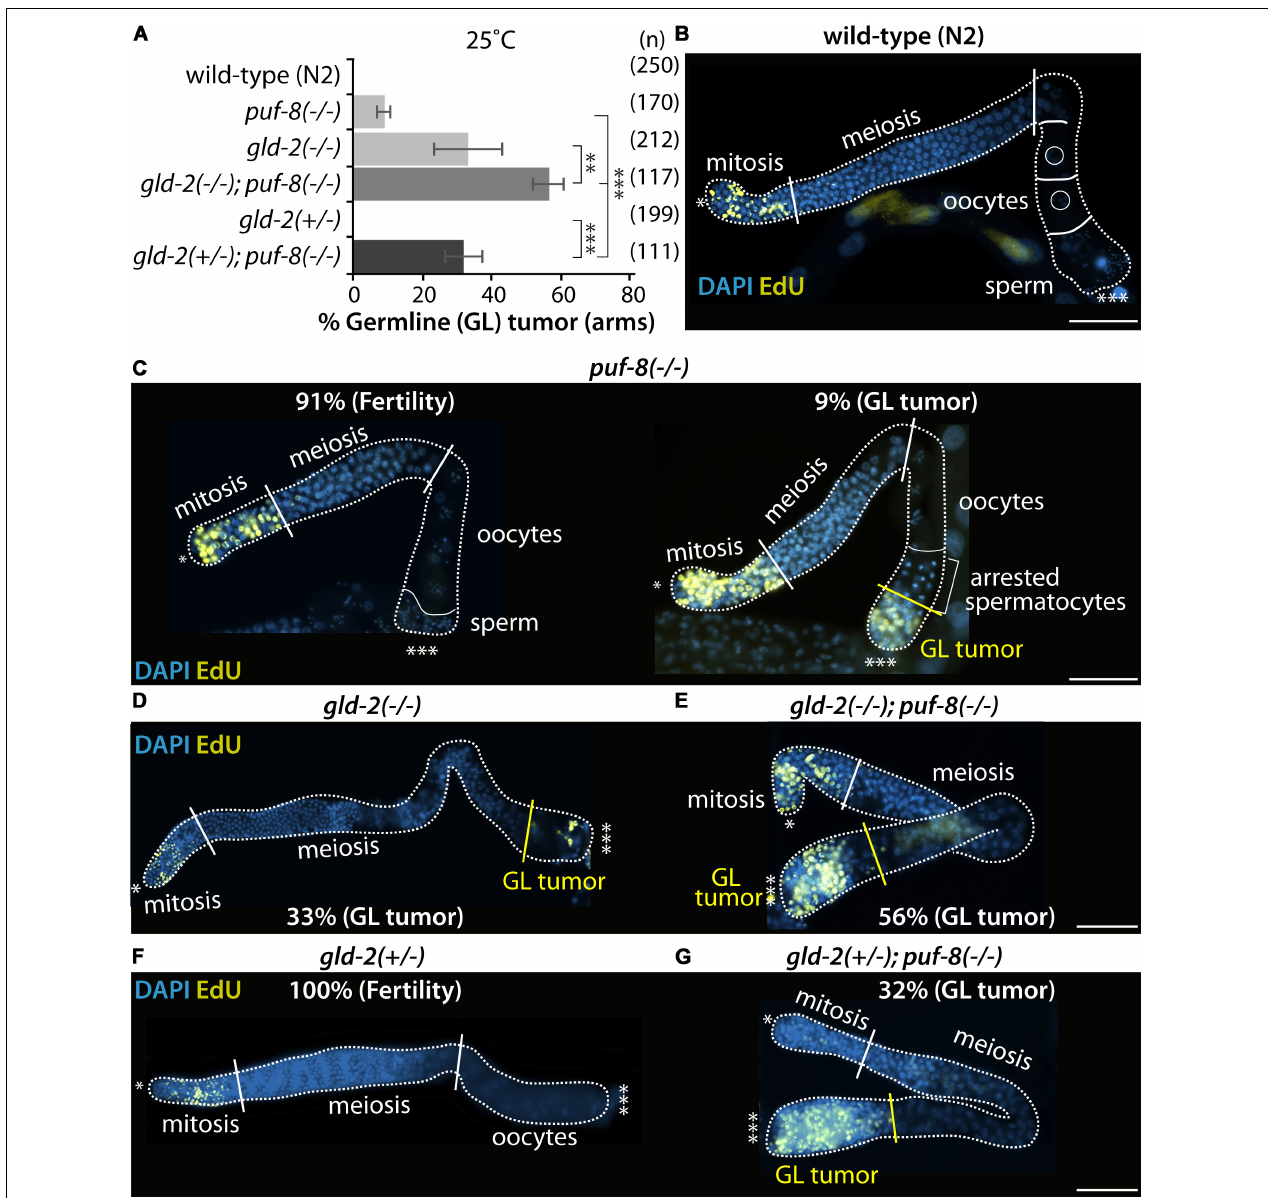
FIGURE 4 | PUF-8 and GLD-2 inhibit the formation of germline tumor. (A) The percentage of germline tumors at 25 ◦ C. The germline phenotypes were analyzed at 4 days past L1 stage. (B–G) Staining of dissected adult hermaphrodite germlines. All were stained using EdU-labeling kit (a marker for mitotic cells) and DAPI (a marker for DNA). ∗ Distal end of gonads; ∗∗∗ proximal end of gonads; white broken lines, the boundary of gonad; white lines, the boundary of different germ cell types: mitotic region and meiotic region, meiotic region and oocytes, oocytes and sperm; yellow lines, the boundary between differentiated cells and dedifferentiated EdU-positive mitotic cells. Scale bars, 50 µ